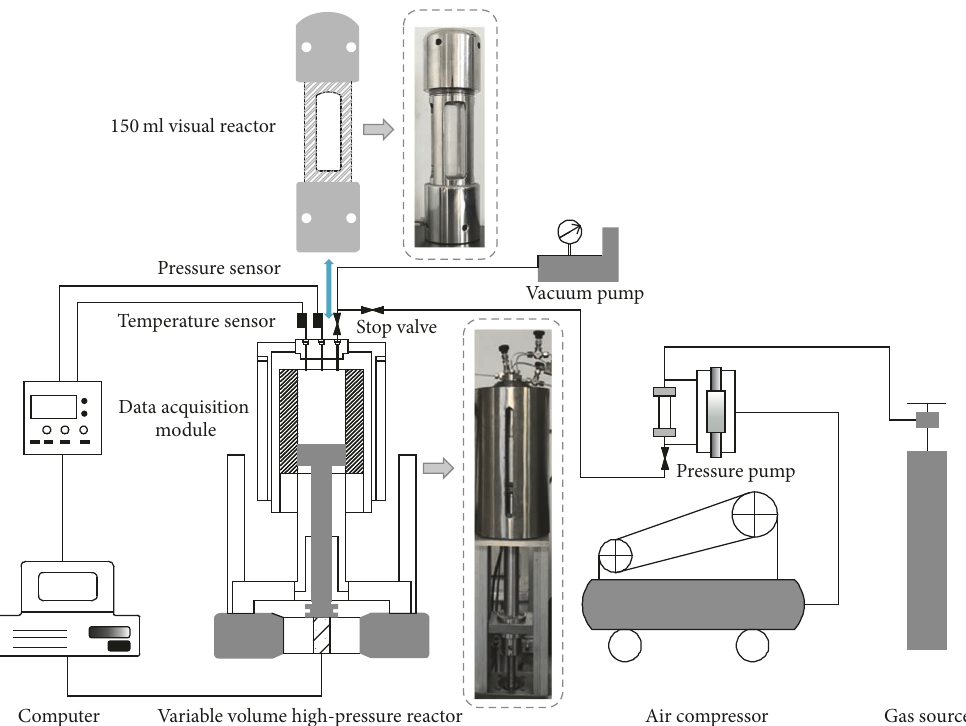
Figure 1: The systematic diagram of mine gas hydrate’s high-pressure experimental